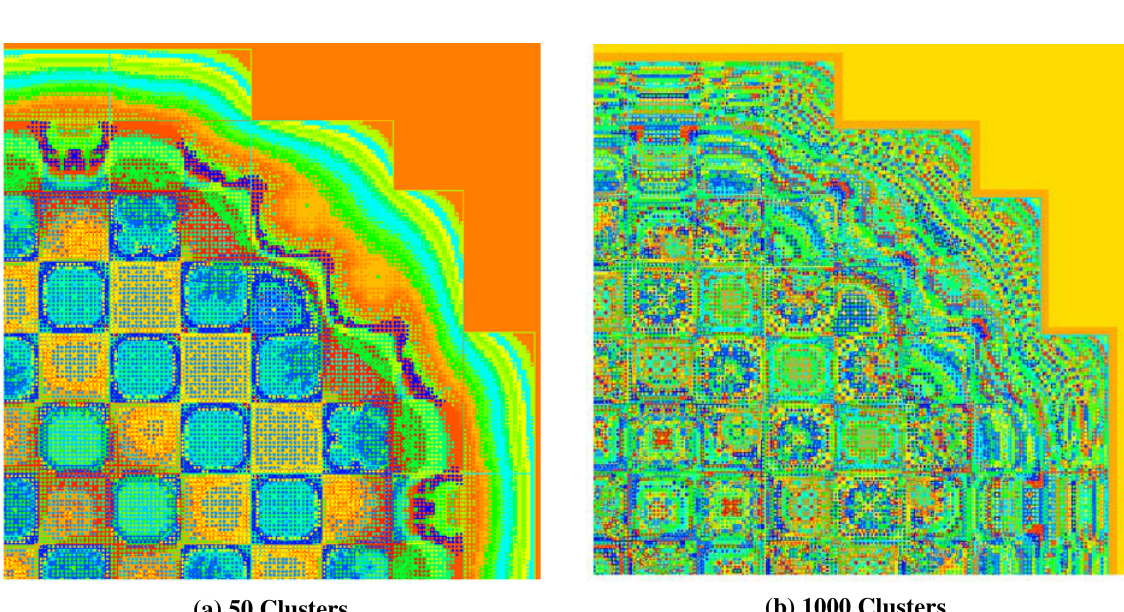
Figure 2: Example clustering of spectra regions with 30 realizations of the k -means